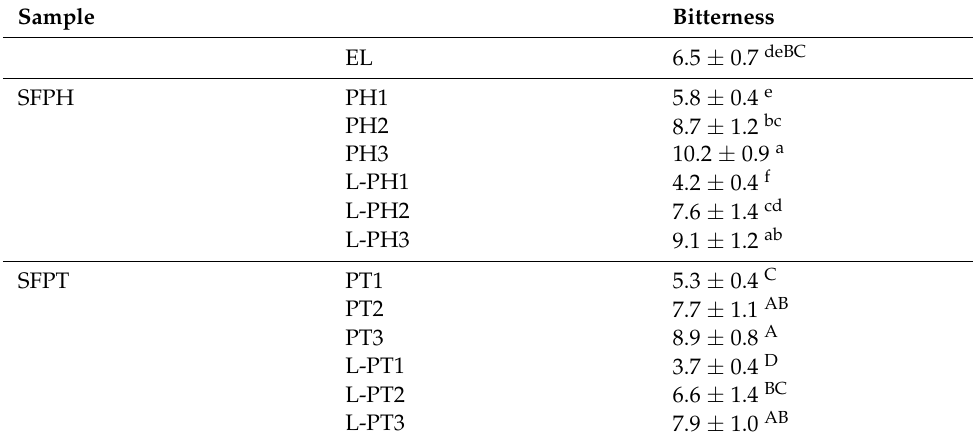
Table 2. Bitterness of liposomes loaded with SFPH and SFPT.